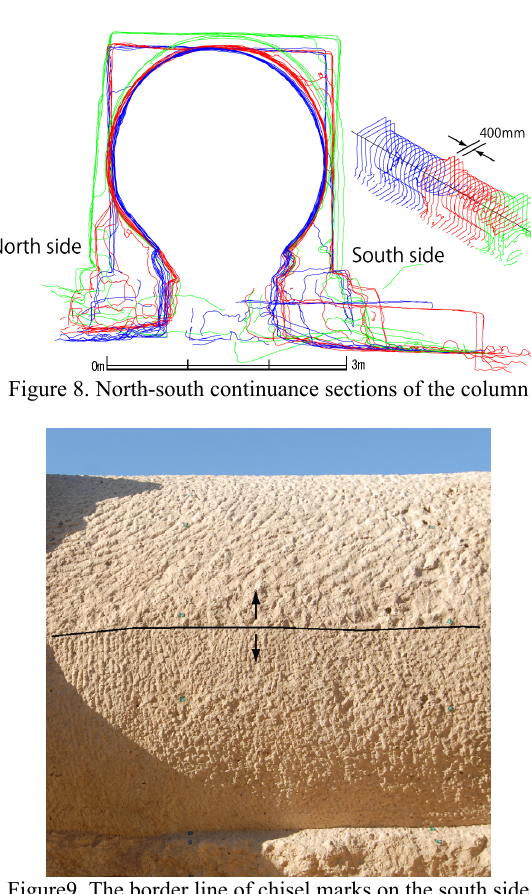
Figure9. The border line of chisel marks on the south side